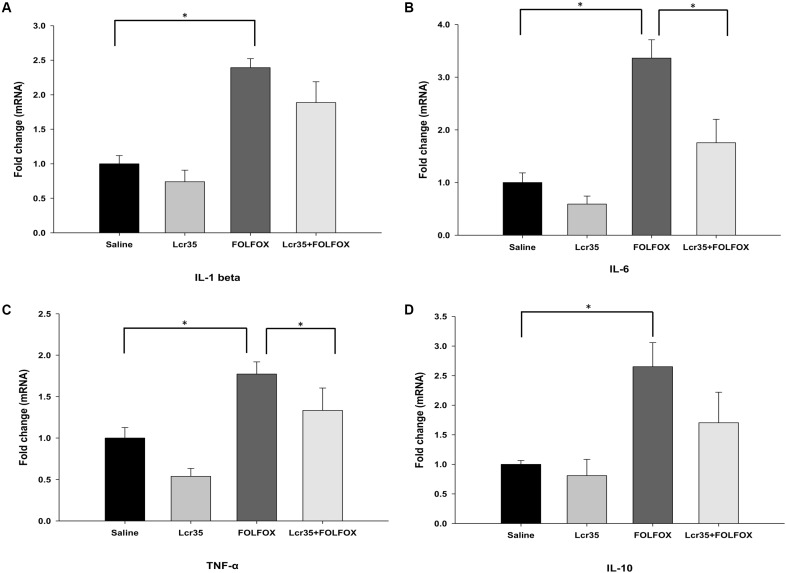
Effects of Lcr35 on Il-1β, Il-6, Tnf-α, and Il-10 mRNA expression in the jejunum of subcutaneously injected colorectal cancer mice challenged with FOLFOX. Gene expression of (A) IL-1β, (B) IL-6, (C) TNF-α, and (D) IL-10 was determined by Q-PCR in jejunum tissues. The mice received saline or Lcr35 (1 × 107 CFU/daily) daily during the experiment. Values are presented as the mean ± SEM. ∗p < 0.05.